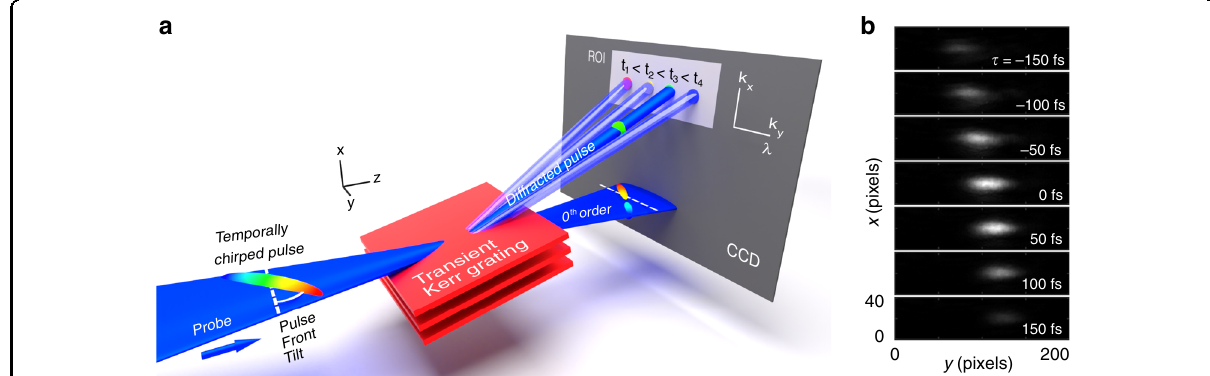
Fig. 4 Visualization of angular dispersion. a Concept of the diffraction of an angularly dispersed probe pulse by the transient grating. The transient grating effectively samples the chirped pulse at the pump – probe delay and diffracts the corresponding sub-pulse on the ROI (region of interest) in the fi rst order of diffraction. b Typical experimental result. Diffracted signal as a function of delay and deviation angle in y